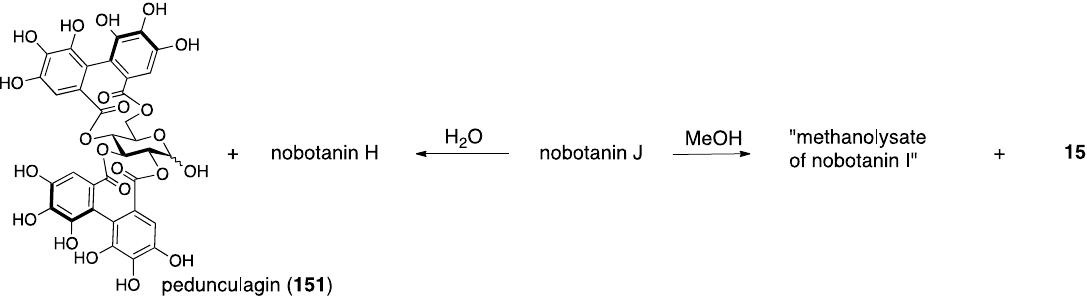
Figure 56. The observations that led to the first structures of nobotanins G, H, and I ( 164 , 166 , and 168 ).